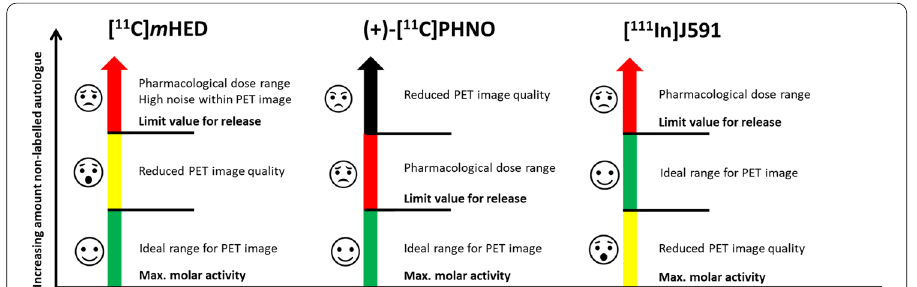
Fig. 4 Examples displaying the connection of molar activity, PET image quality and pharmaceutical dose. (left) [ 11 C]mHED, requires high A m for sufficient quality of the PET scan. Before a pharmacological dose is reached the image quality is affected. (middle) [ 11 C]PHNO requires high A m for patient application and safety. At first a pharmacological effect, like nausea, is observed before the quality of the PET image is influenced. The release criteria has to be strictly followed for this kind of compounds to avoid any side or toxic effects. (right) [ 111 In]J591 is reported to have a low lesion to non-lesion residence time if the molar activity is high. Higher amounts of non-labelled autologue increases the residence time and subsequently the quality of the